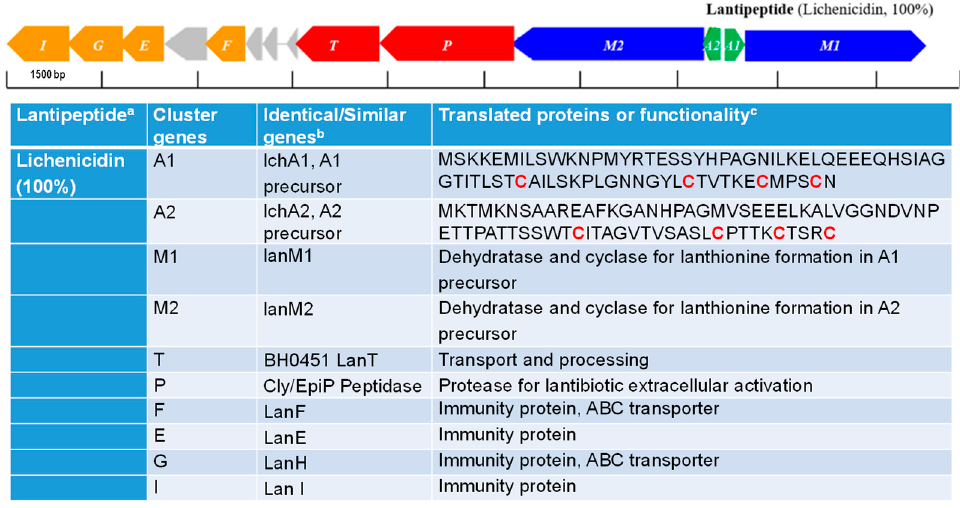
Figure 4. Gene cluster associated with the synthesis of Lichenicidin identified in the genome of B. licheniformis CG1. The color of the arrows indicate the nomenclature for genes encoding for: hypothetical precursor peptides (green arrows), posttranslational modification enzymes (blue arrows), transport/processing proteins (red arrows), immunity proteins (orange arrows) and hypothetical proteins (grey arrows). The hypothetical RiPPs are indicated next to each cluster, on the right-hand side, along with their corresponding identity alignment scores when compared to similar RiPPs (in brackets). In the Table: a percentage of similarity (indicated in brackets) with described lichenicidin; b Similarity with proteins reported previously; c cysteines involved in the lanthionine biosynthesis (indicated in red).